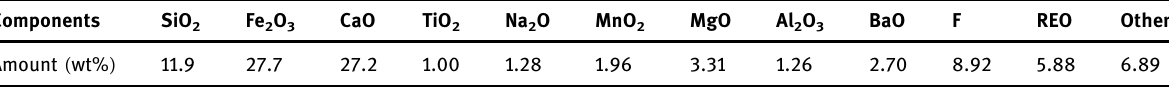
Table 1: Chemical composition of Bayan Obo mine tailings Components SiO 2